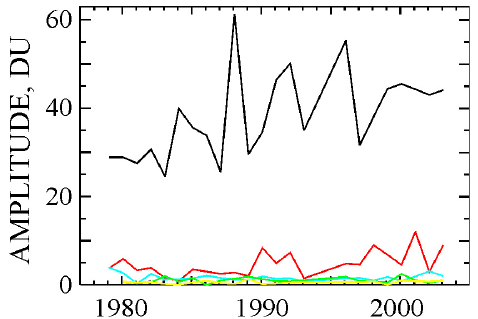
Fig. 8. Interannual variations of the stationary component ampli- tude A mst of the wave numbers 1–5 (the colors are the same as in Fig. 6).